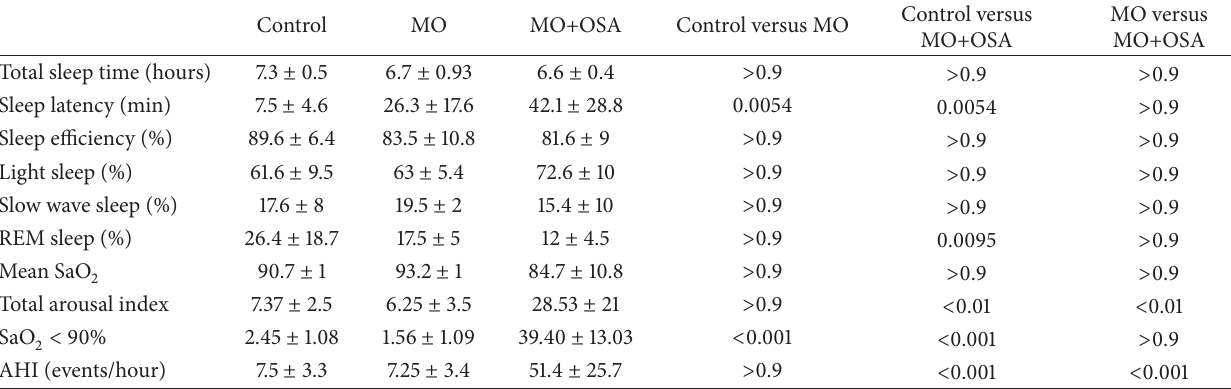
Table 2: Polysomnographic characteristics of the study subjects.